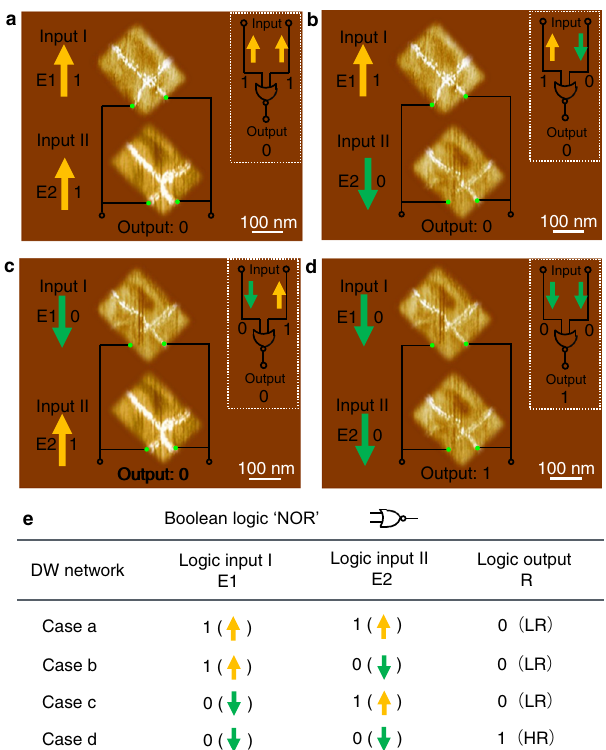
Fig. 3 Recon fi gurable NOR logic gate. a – d c-AFM images and corresponding logic circuit diagrams of two parallel-connected nano-islands with the sequence of logic operations for inputs of ‘ 11 ’ , ‘ 10 ’ , ‘ 01 ’ , and ‘ 00 ’ . e Truth table for the NOR logic gate. E1 and E2 are the applied in-plane trailing fi elds for the two